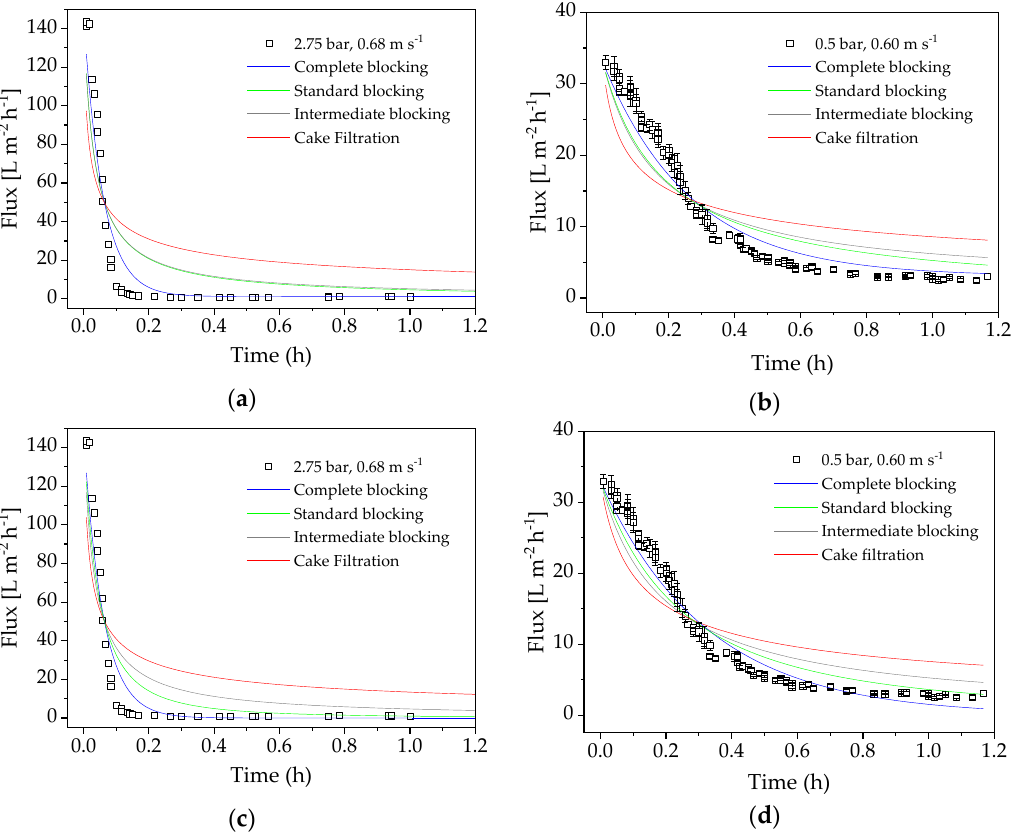
Figure 8. Adaptation of dead-end and cross-flow filtration models. ( a ) Center point (2.75 bar, 0.68 m · s − 1 ): dead-end models. ( b ) Optimized confirmation run parameters (0.5 bar, 0.6 m · s − 1 ): dead-end models. ( c ) Center point (2.75 bar, 0.68 m · s − 1 ): cross-flow models. ( d ) Optimized confirmation run parameters (0.5 bar, 0.6 m · s − 1 ): cross-flow models.